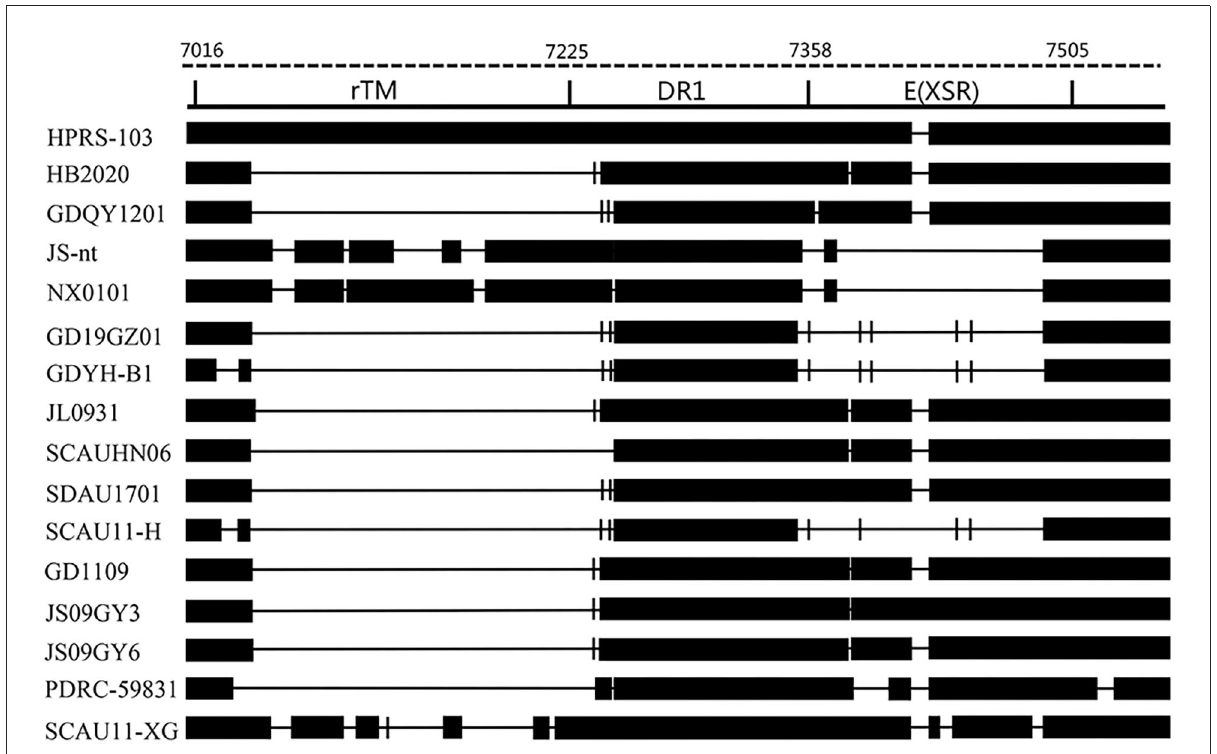
FIGURE7 Comparison of the nucleotide and important regulatory elements of the HB2020 and other ALVs’ 3’UTR regions.